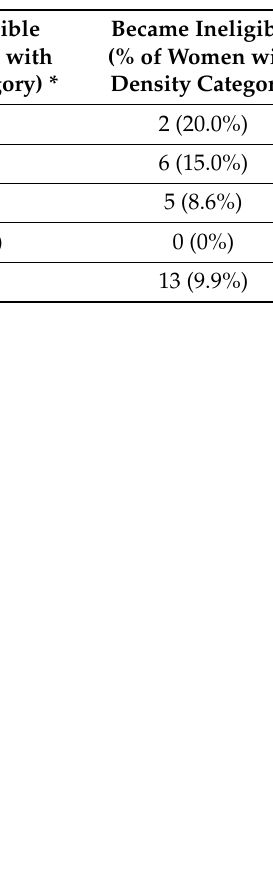
Table 2. Eligibility according to ACR BI-RADS categories of breast tissue density.